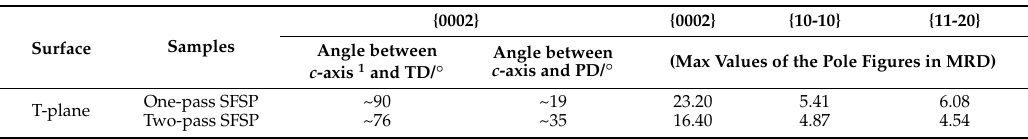
Table 2. Detailed statistical results about the texture in SFSP alloys and the angle between the c -axis and TD or ND.